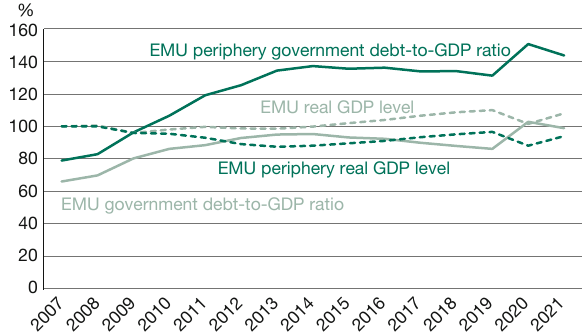
General government debt-to-GDP ratio and real